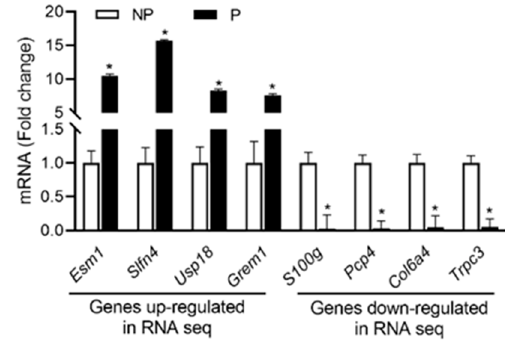
Figure 3. qRT-PCR validation of the four up and downregulated genes from RNA sequencing data. Quantitation of fold change was normalized relative to Gapdh levels. Values are given as means ± standard error of the mean (sem) of n = 3 per group (* P < 0.05). NP-non-pregnant; P-pregnant.